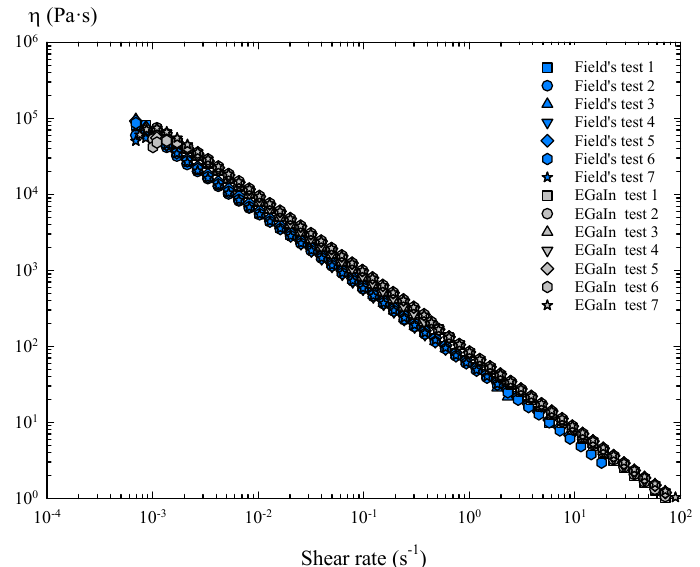
Figure 10. Viscosity curves of oxidized Field’s metal and EGaIn obtained in the torsional flow ramp tests.